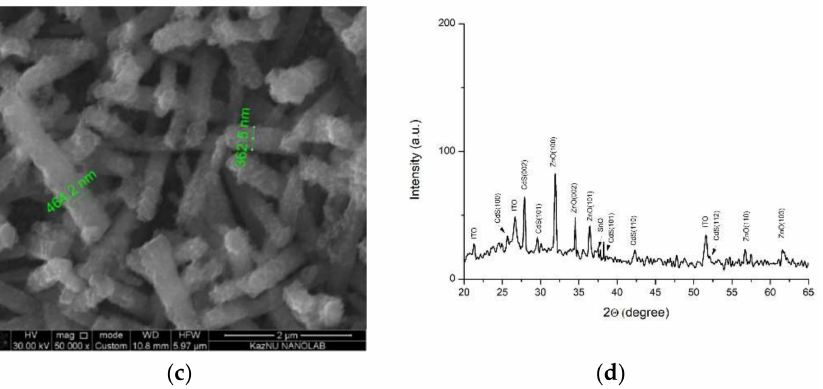
Figure 3. ( a ) SEM image of 10 layers of CdS; ( b ) SEM image of 20 layers of CdS; ( c ) SEM image of 30 layers of CdS, and ( d ) X-ray diffraction analysis.